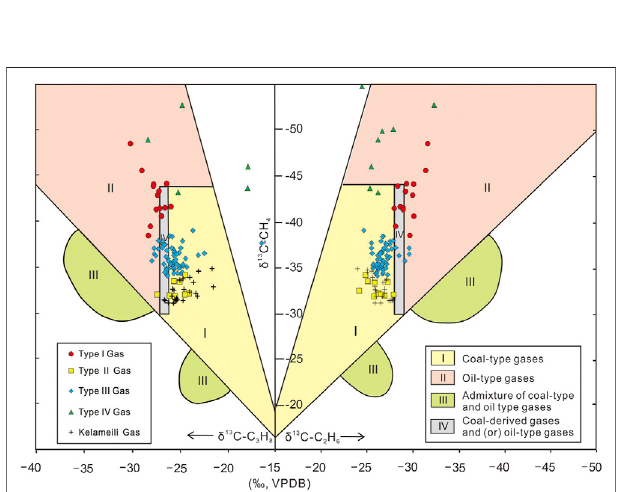
FIGURE 3 | The δ 13 C distribution pattern of natural gas in the hinterland of Junggar Basin.